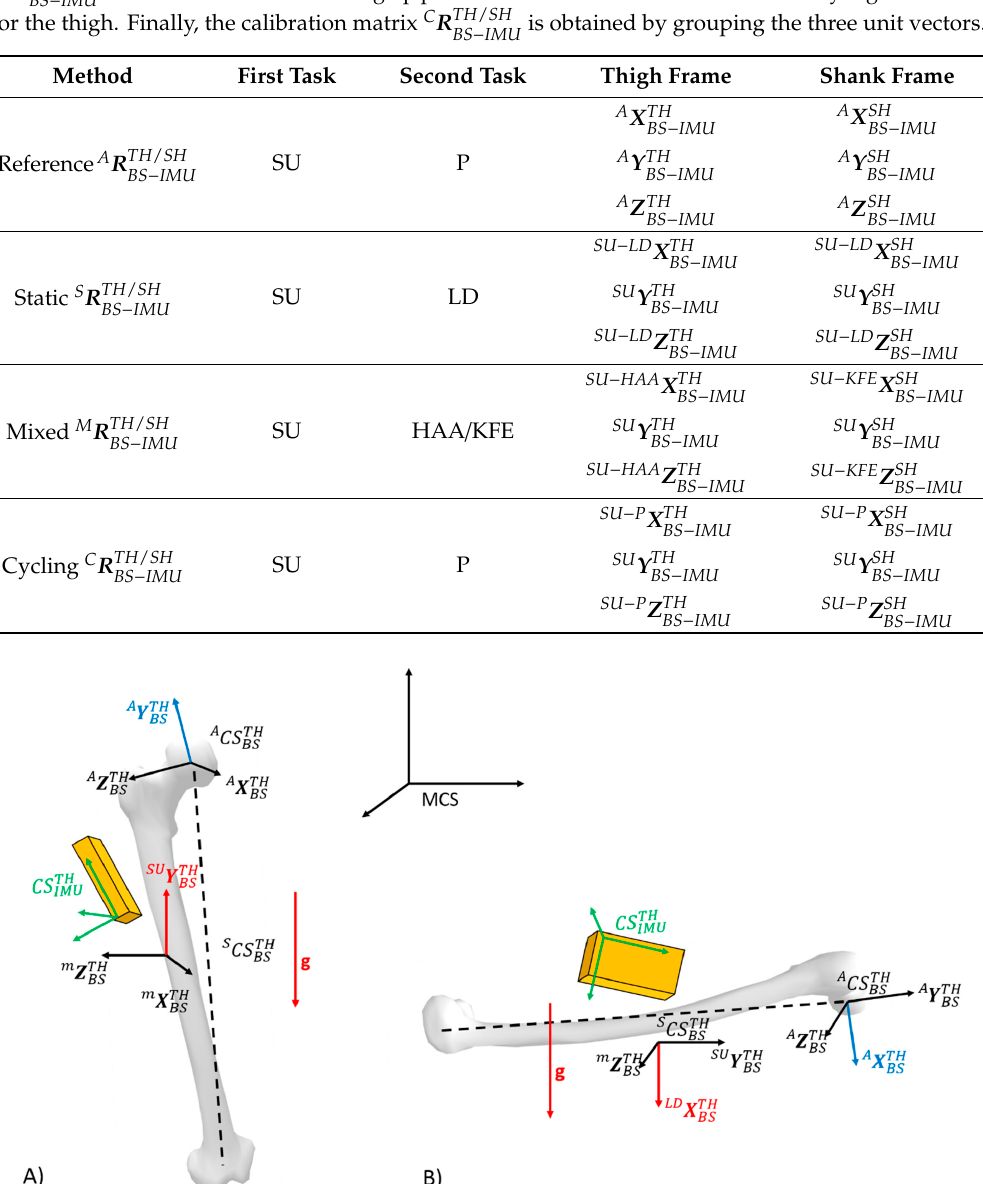
Figure 3. Illustration of the static calibration procedure for the thigh including all considered coordinate systems. The red vectors represent the gravity vector and the axis of the technical body-segment frame which components have to be estimated with respect to the IMU frame for a given task. More specifically, components of SU Y TH are estimated from SU task ( A ) whereas components of LD Y TH estimated BS − IMU BS − IMU from LD task ( B ). The same procedure can be developed for the